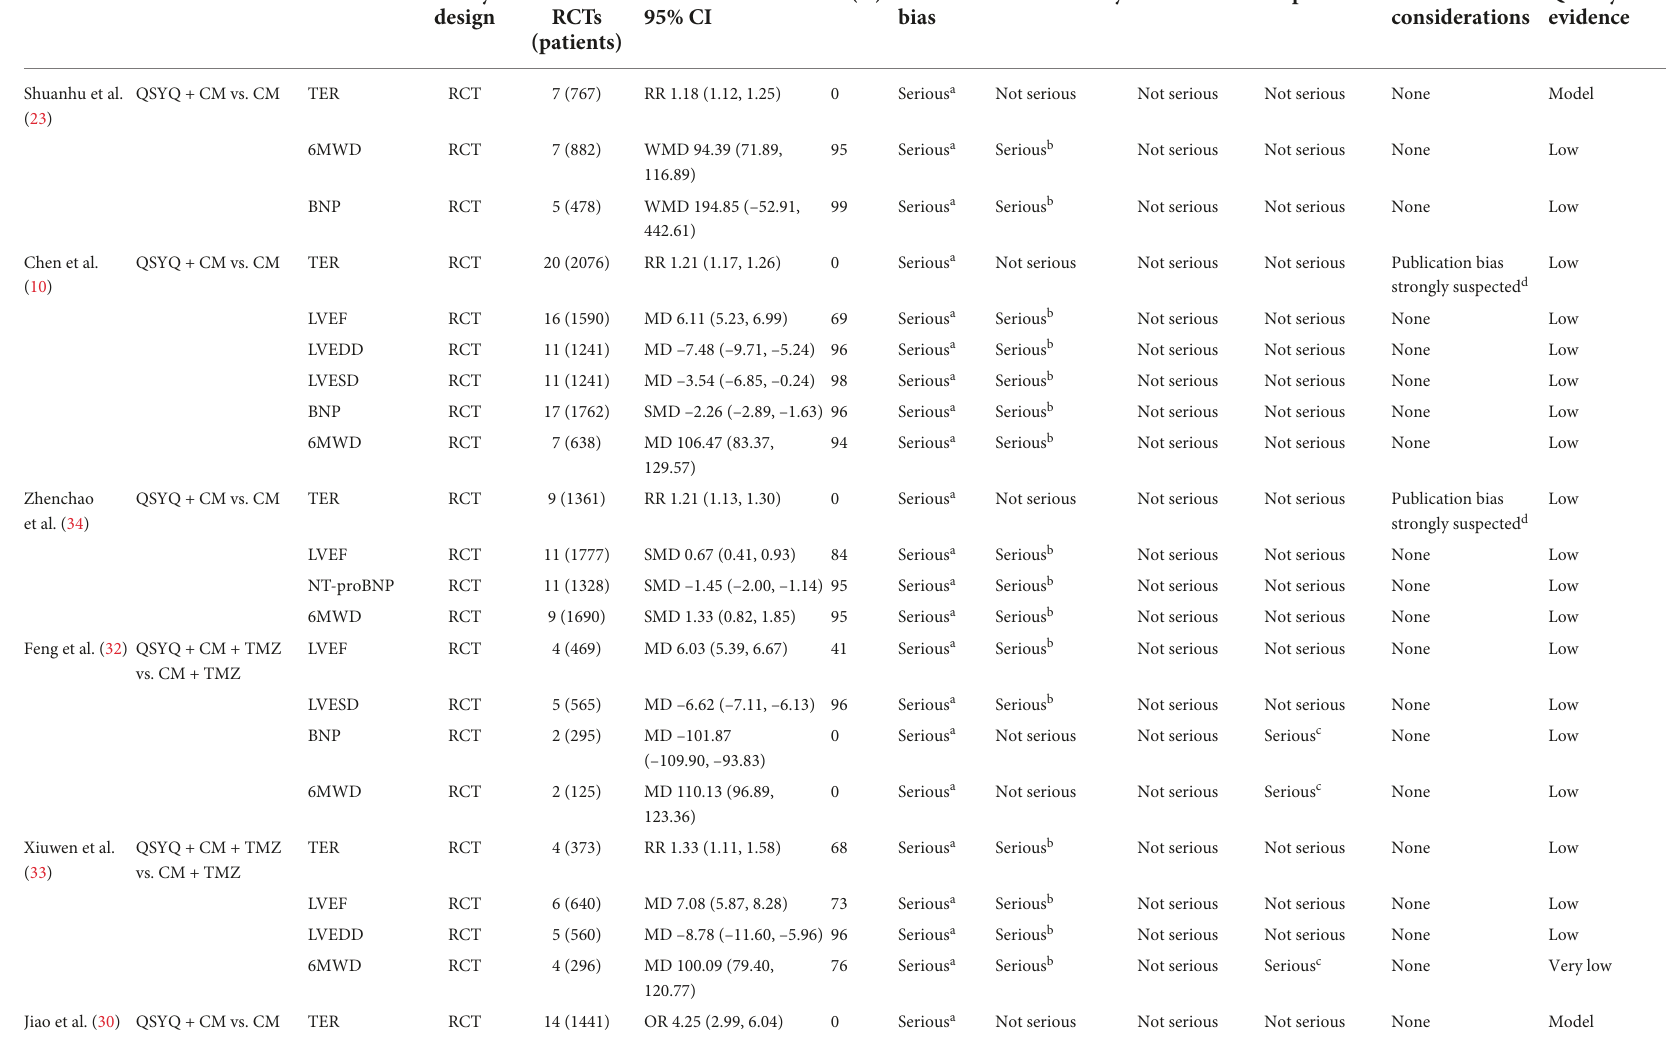
TABLE 6 Quality of evidence in the included systematic reviews based on